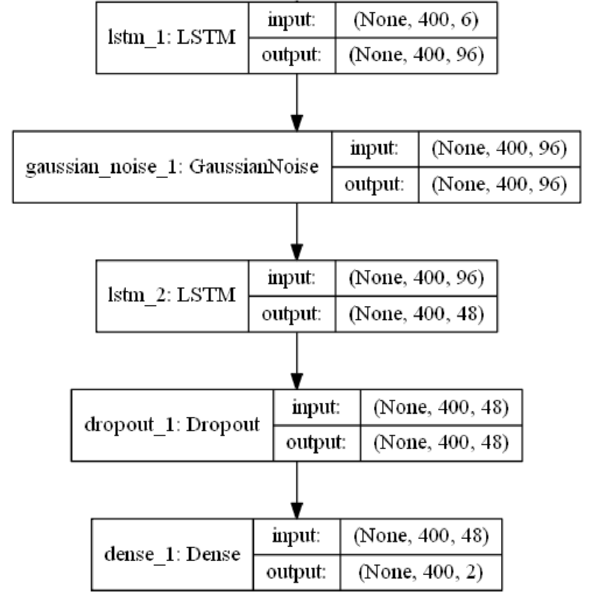
Figure 10. Structure of the long short-term memory (LSTM) neural network regression models used for predicting vertical ground reaction forces (vGRF) and ground contact time